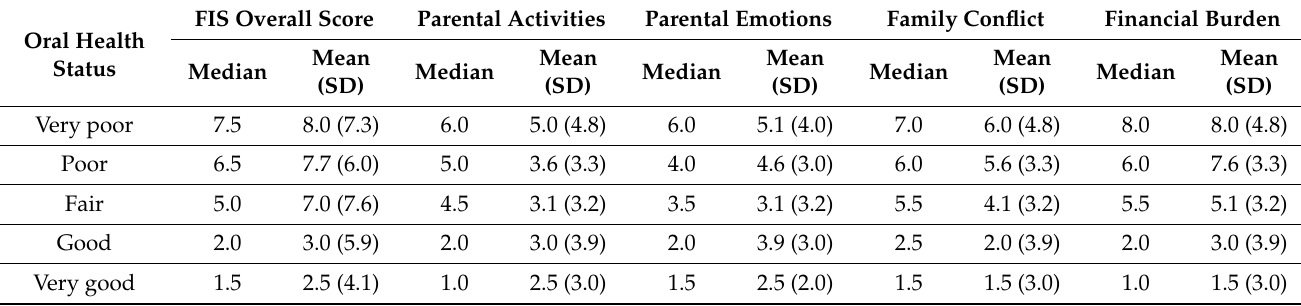
Table 2. Findings from discriminant validity of the overall and subscale scores by perceived oral health status. Oral Health